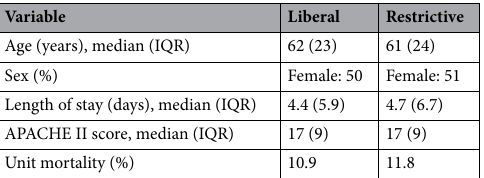
Table 2. Patient level characteristics of liberal and restrictive magnesium supplementation groups.